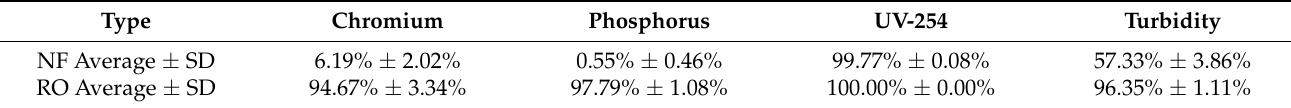
Table 5. Average ± SD at different pressures.